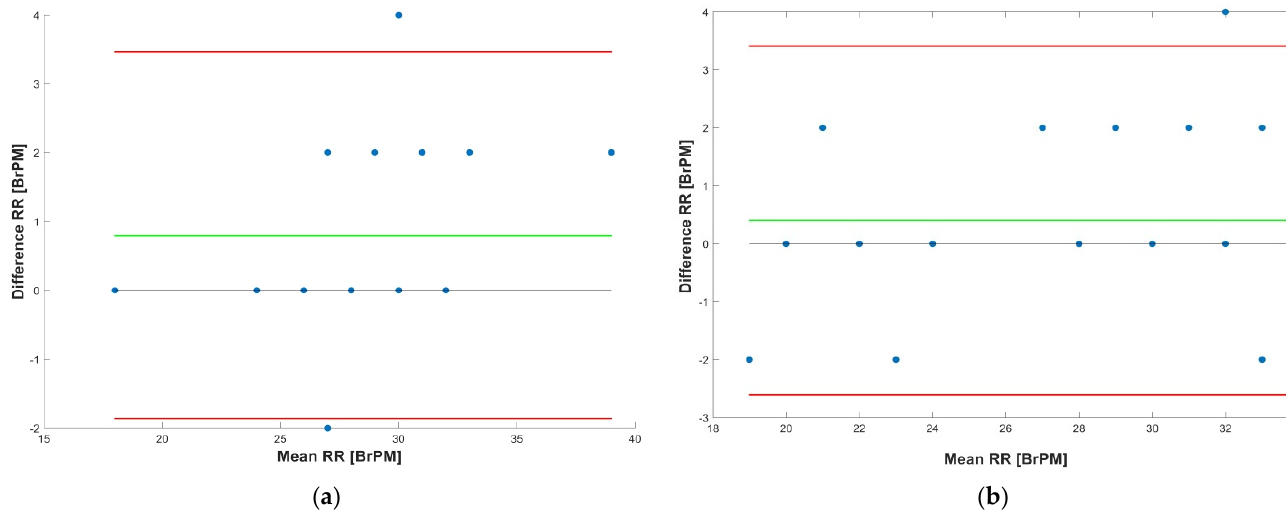
( c ) Figure 11. Bland–Altman graphs of the measurements obtained by the developed chest band and those obtained by breath counting when the user is: seated ( a ), standing ( b ), and walking ( c ). 4. Discussion In this section, the experimental results reported previously are analyzed and dis- cussed to evaluate the performance of the developed wearable device. Then, a perfor- mance comparison with similar systems presented in the literature is presented. Considering the seated user, the correlation coefficient was equal to 0.958, whereas it was 0.956 when standing and 0.923 when the user walks (Figure 10). The high value of the Pearson coefficient indicates that the measurements of the chest band are strongly correlated with the corresponding measurements obtained by counting breaths, which are used as a reference. However, considering the measurements for walking users (r = 0.923), a slight deg- radation of the sensor accuracy was observed compared to stationary users (r = 0.958—seated user, and r = 0.956—standing user). The discrepancy between measure- ments is caused by false peaks induced by the body movements, which were not re- moved by analyzing the inertial data acquired by the onboard accelerometer. However, the device performance can be enhanced by optimizing the acceleration threshold in-